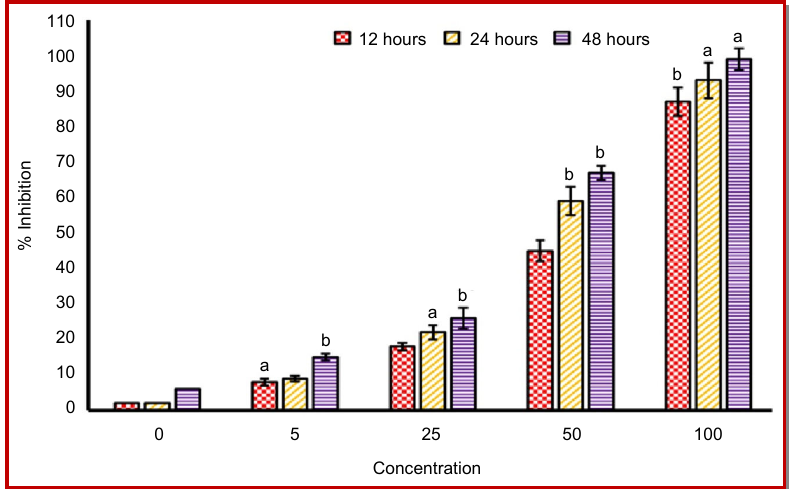
Figure 2: Anti-proliferative effects of lactucin in HL-60 human leukemia cancer cells. Data are shown as the mean ± SD of three independent experiments. a p<0.05, b p<0.01 vs 0 µM